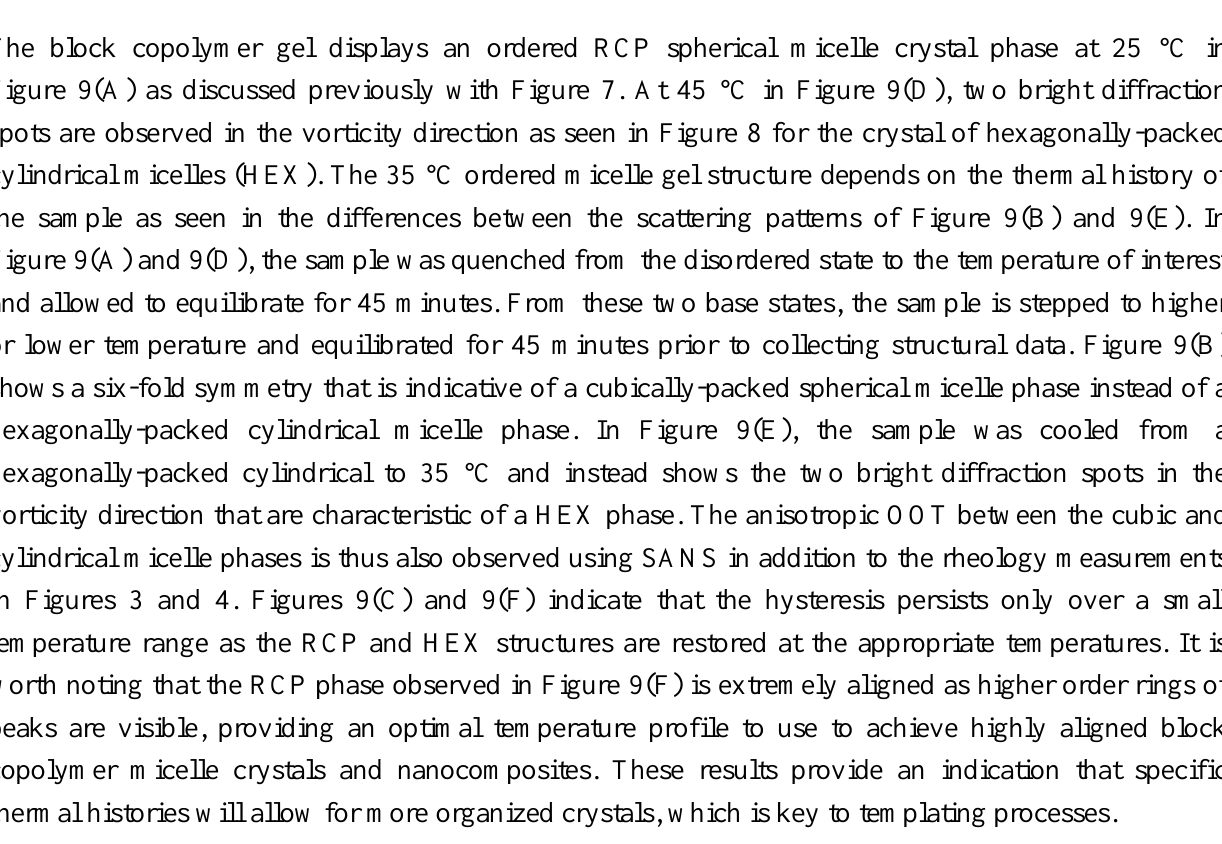
Figure 9. Two dimensional SANS intensities (radial, oscillatory shear) for a series of different thermal histories on 35 wt% block copolymer in water. One series involves quenching the sample from disordered to ( A ) 25 °C, then ( B ) heating to 35 °C and ( C ) 45 °C holding for 45 minutes at each temperature. In the second series, the same sample is quenched from disordered to ( D ) 45 °C, then ( E ) cooling to 35 °C and ( F ) 25 °C holding for 45 min at each